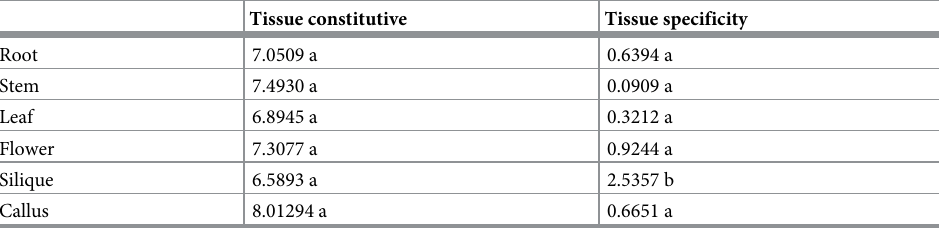
Table 2. The expression level in different tissues between constitutive and specific positively selected